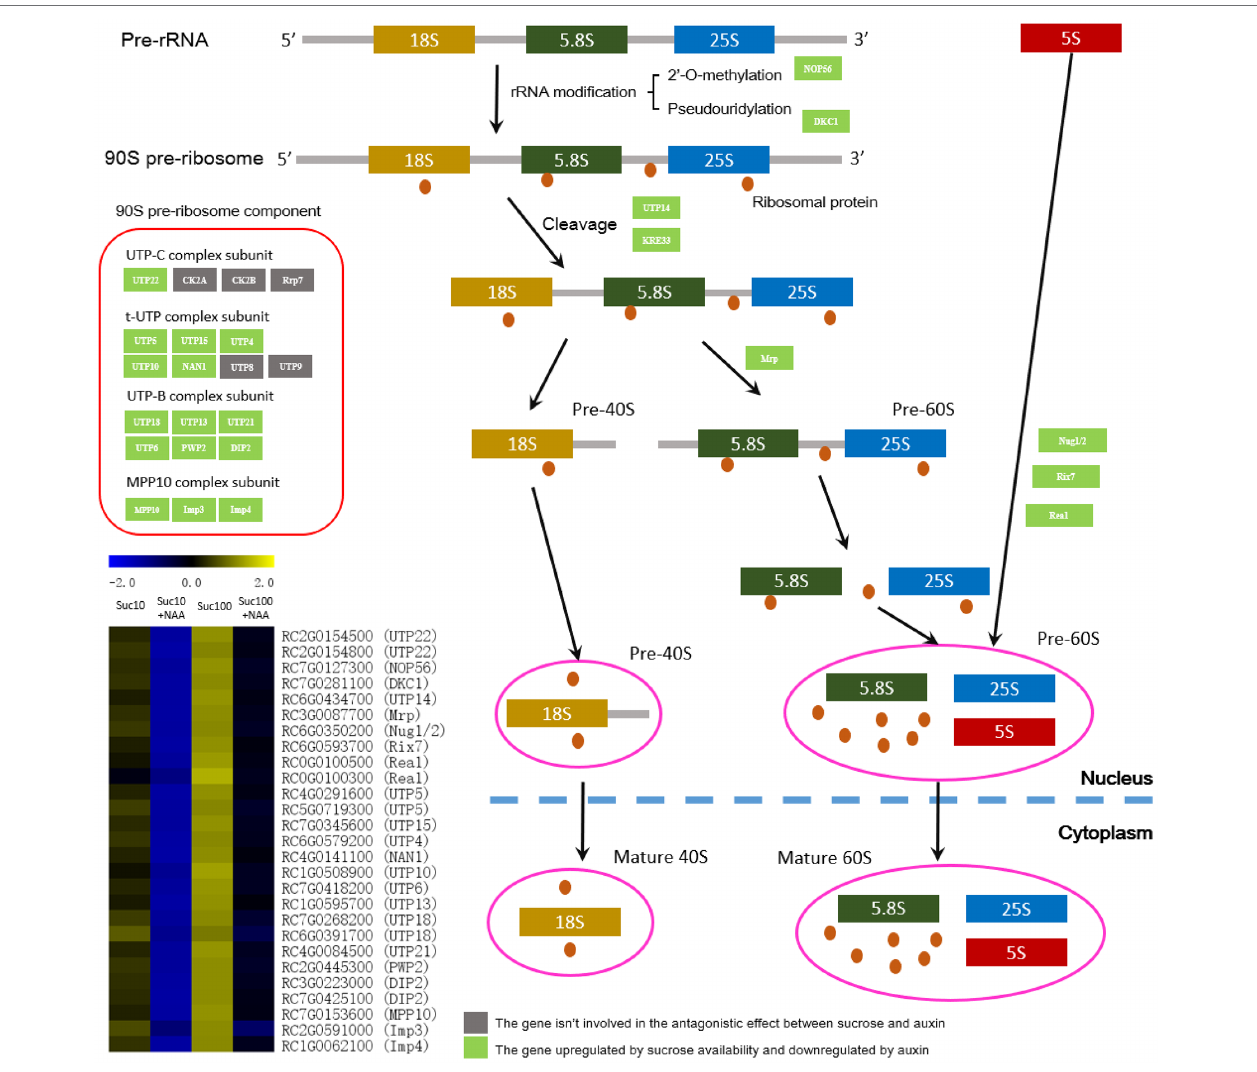
FIGURE 6 | The ribosome biosynthesis machinery is affected by the antagonistic effect of sucrose and auxin. Suc10, 10 mM sucrose; Suc10 + NAA, 10 mM sucrose + 1 μ M NAA; Suc100, 100 mM sucrose; and Suc100 + NAA, 100 mM sucrose + 1 μ M NAA. Dark green labels, enzymes-encoding genes repressed by auxin but stimulated by sucrose. Gray labels, enzymes-encoding genes repressed by sucrose but stimulated by auxin. Heatmap color (from blue to yellow), gene transcription level from low to high,